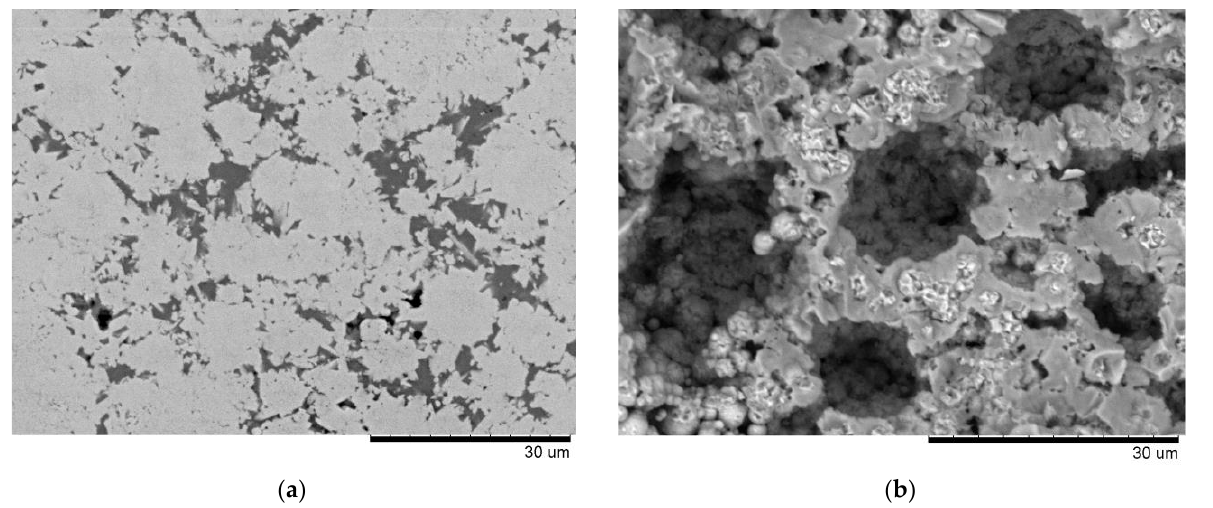
Figure 10. ( a ) Microstructure of the material obtained by SPS of Al-Fe (4:1 mol.) mixture. Al powder 3 – 10 μm. SPS conditions: temperature— 570 °C, holding time — 3 min, applied pressure — 40 MPa. ( b ) Fracture surface of the material obtained by HP of the Al-Fe (3:2 mol.). Al powder 3 – 30 μm . HP conditions: temperature — 650 °C, holding time — 5 min, applied pressure — 3 MPa. BSE images.